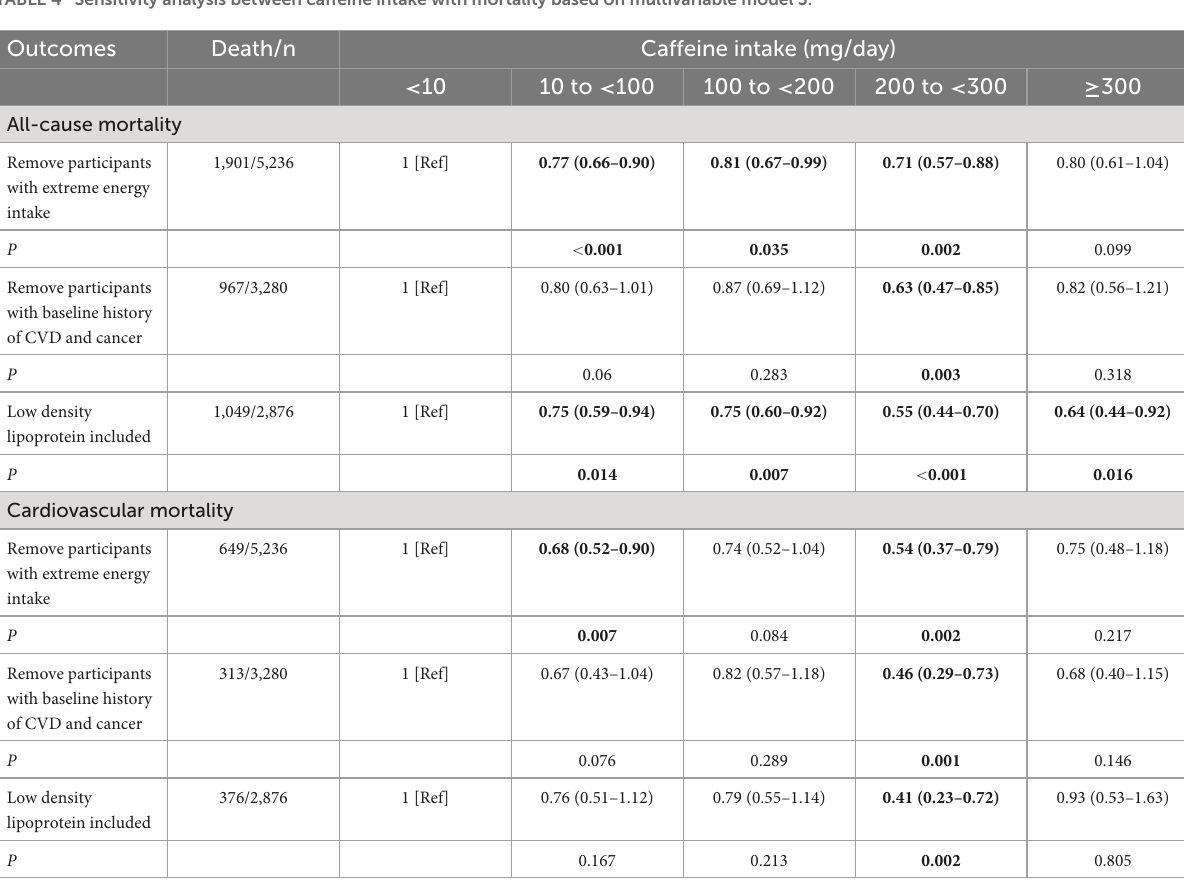
TABLE 4 Sensitivity analysis between caffeine intake with mortality based on multivariable model